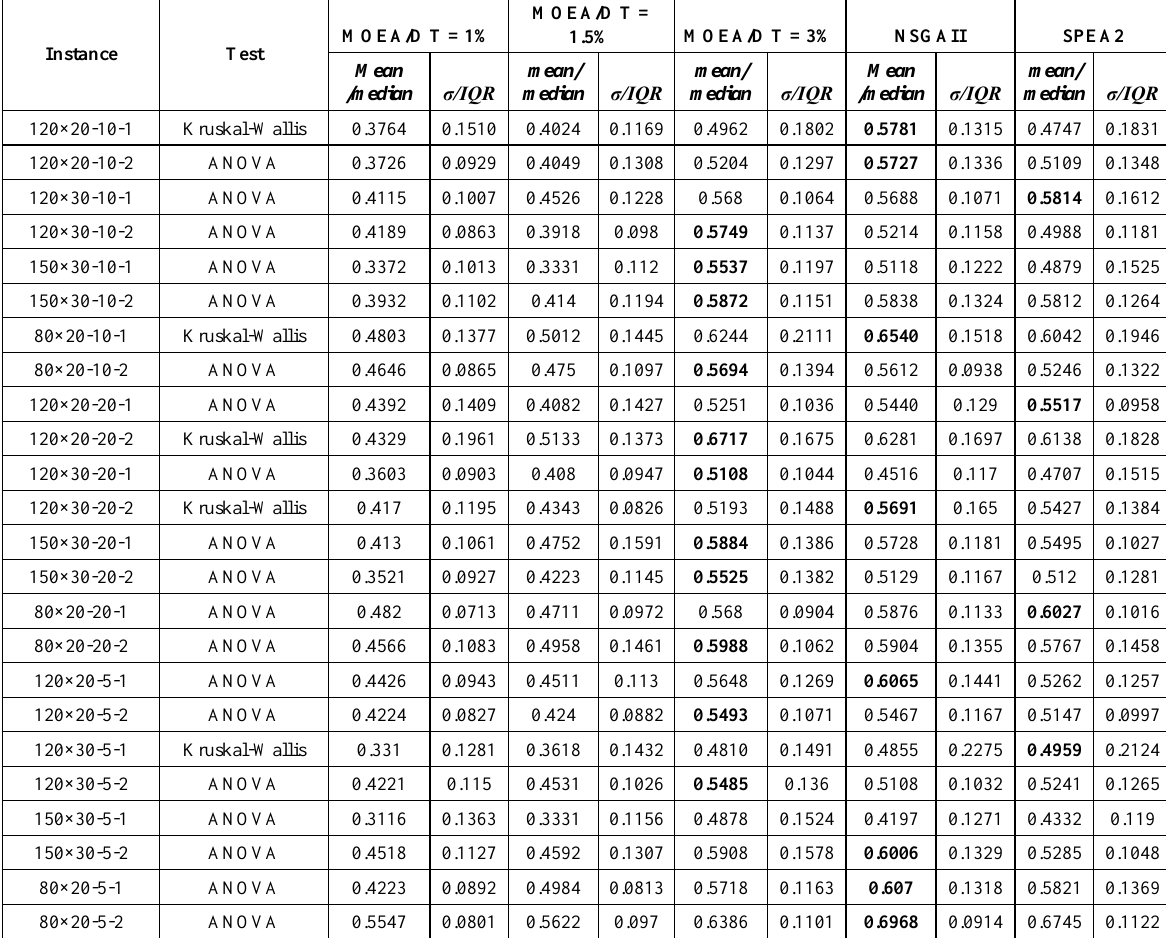
Table 6. RHV comparison with baseline NSGAII and